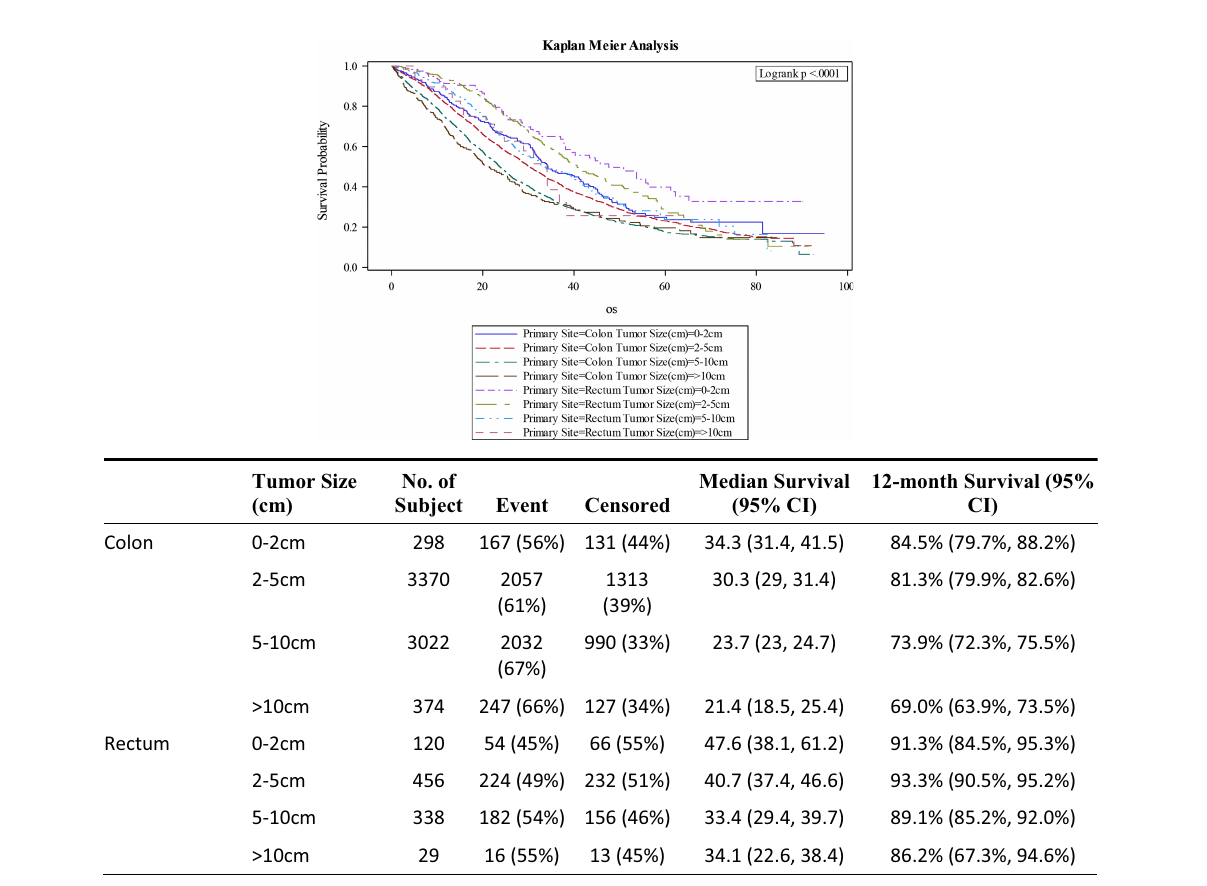
FIGURE 2 | Overall survival for Stage IV CRC strati fi ed by tumor